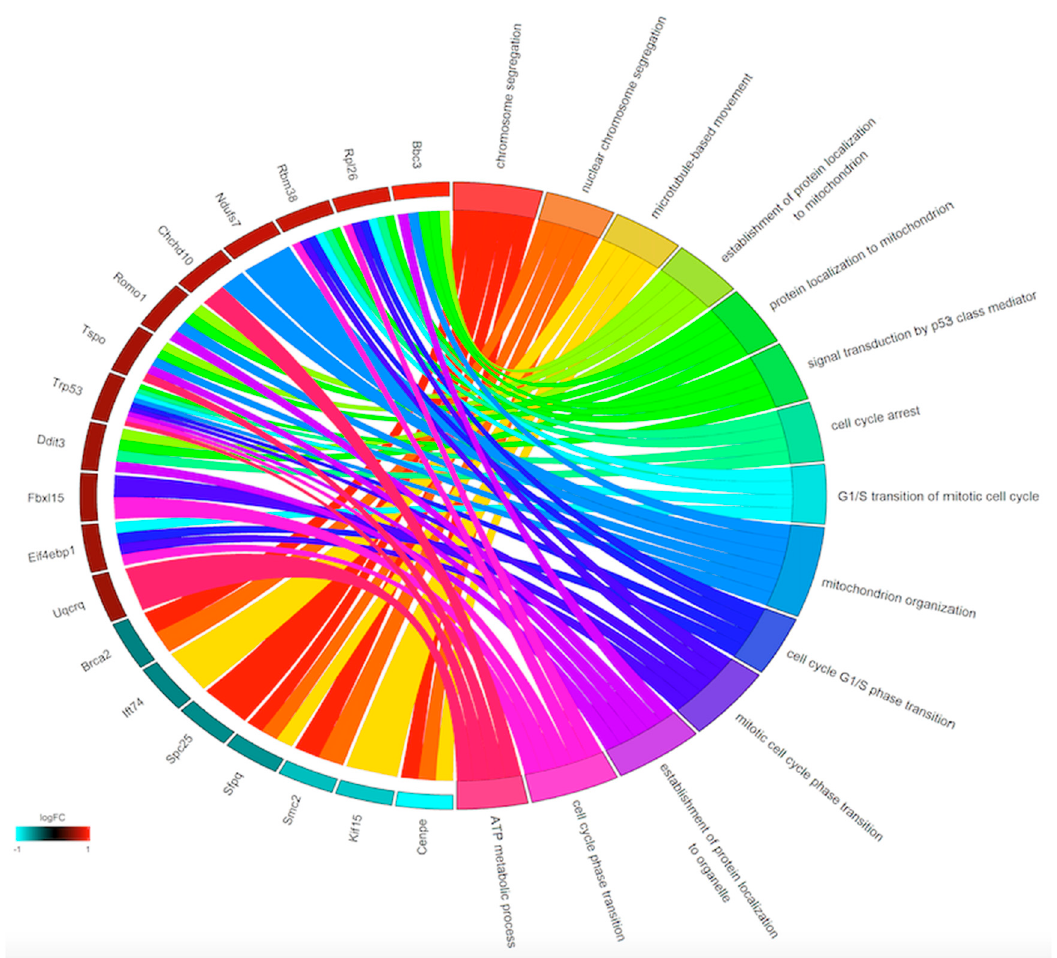
Figure 3. Enriched GO biological process terms identified after DENV infection and APAP treatment. Enriched GO biological processes are shown on the right and differentially expressed genes are shown on the left. On the left side, each gene is represented by a rectangle and the color transition from green to red indicates the log fold change of the expression levels. Upregulated genes are displayed in red whereas downregulated genes are displayed in blue. On the right side, each GO term is represented by a colored rectangle. Chords connect genes (Ensembl IDs) with the biological process (GO terms).